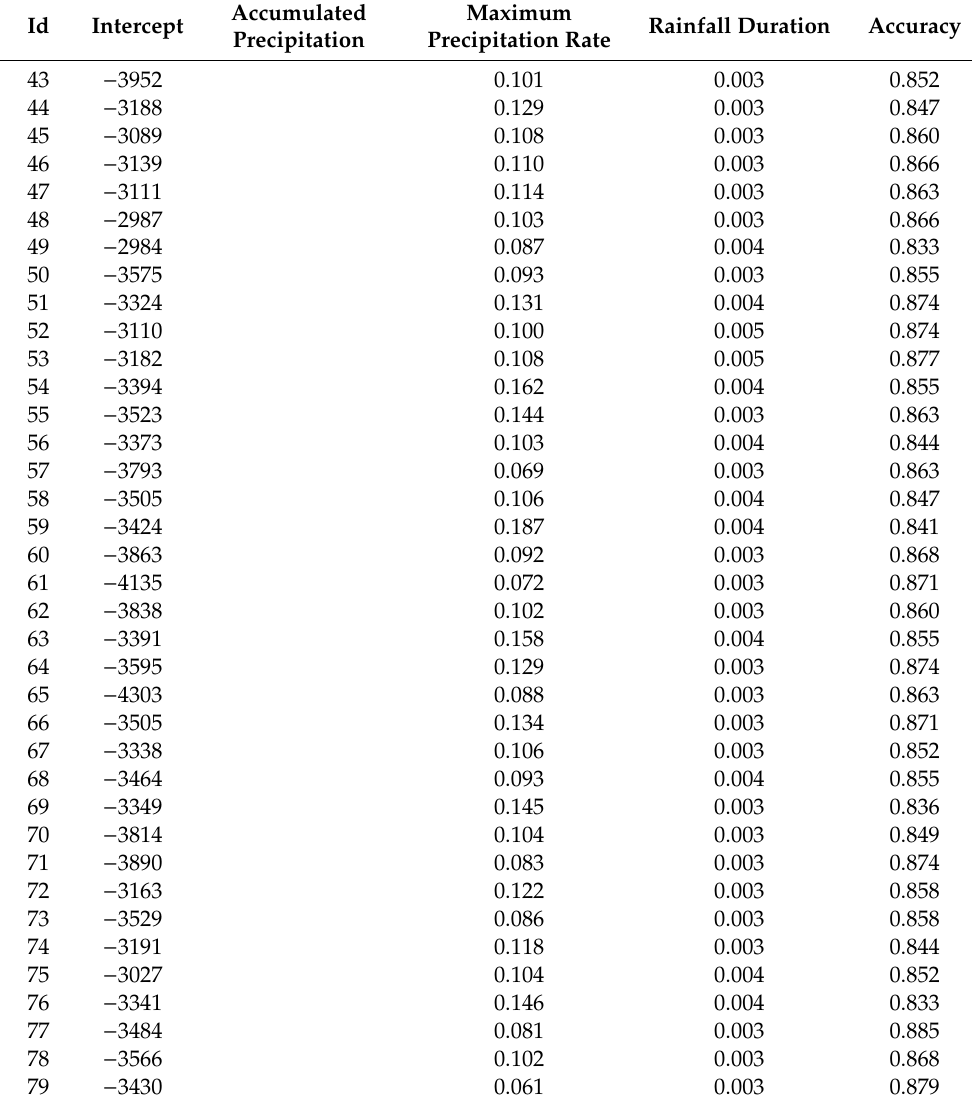
Table A4. Logistic regression model coe ffi cients for the two variables included a maximum precipitation rate and rainfall